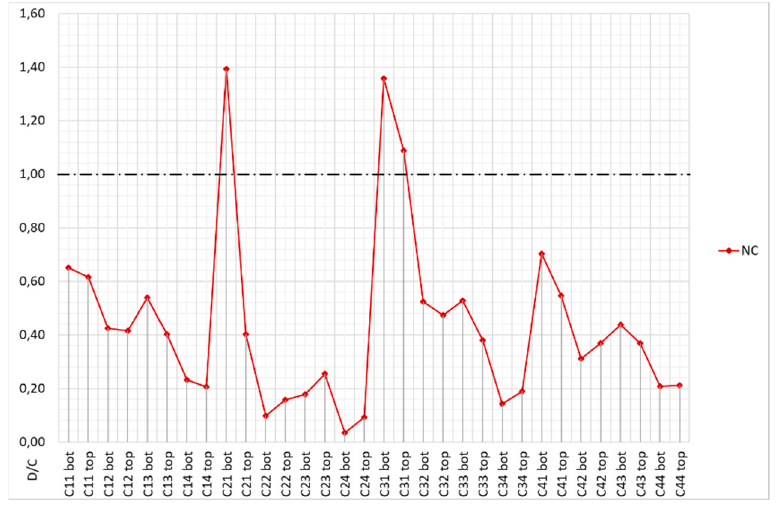
Figure 11. DCM: NC shear force 𝐷 𝐶⁄ ratios on columns (pushover analysis).